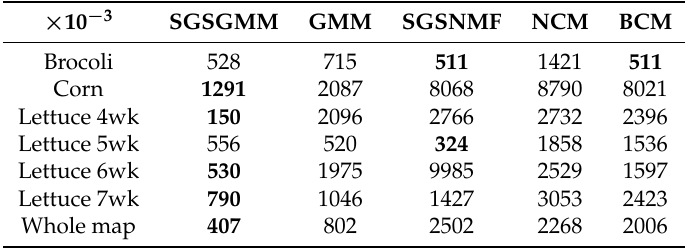
Table 5. Abundance errors for Salinas-A dataset.